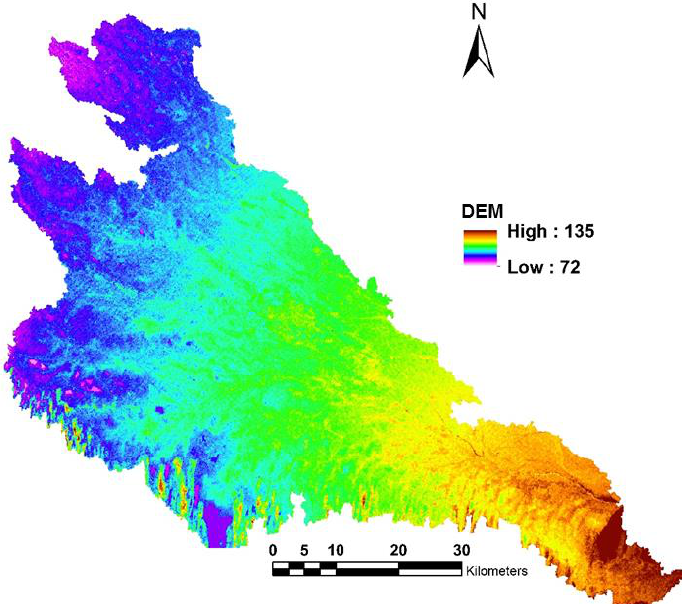
Figure 3. Digital Elevation Model (DEM) of the Khorezm region, Uzbekistan. Source: [43]. Data from five locations in Khorezm were processed to capture the spatial variability